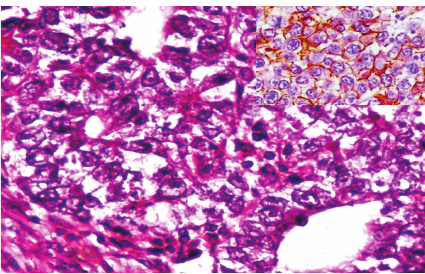
Figure 2: Micrograph showing nests of large pleomorphic typical epithelial cells with vesicular nucleus, prominent nucleoli, abundant cytoplasm, and poorly defined cell borders. H & E Stain × 40x. Inset: CD30 membranous positivity in the tumor cells IHC CD30 ×